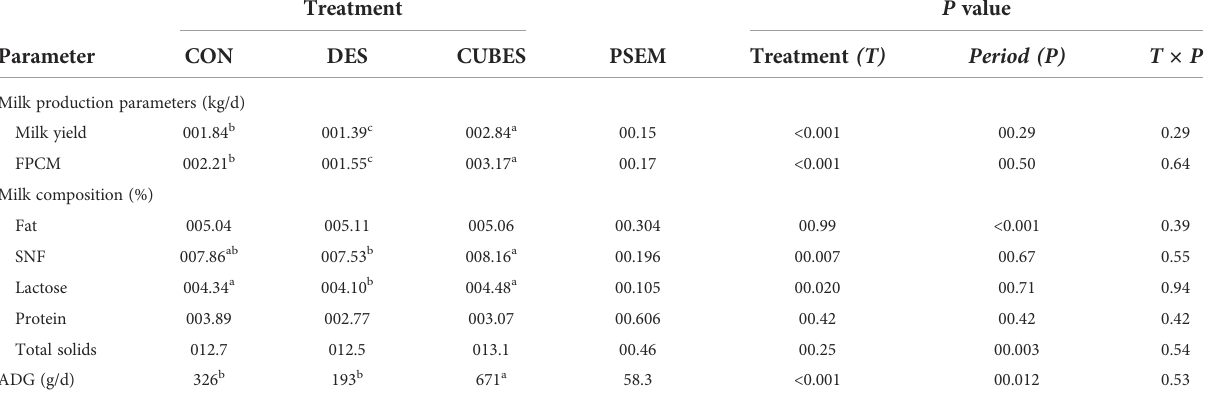
TABLE 5 Daily milk production, milk composition and average daily gain (ADG) of crossbred cows ( n =12) fed either on a control diet (CON) consisting mainly of Urochloa brizantha var. Xaraes hay alone or the control diet supplemented with either Desmodium intortum hay (DES) or a commercial dairy supplement (CUBES) over 3 feeding periods with the measurements lasting for 28 d.